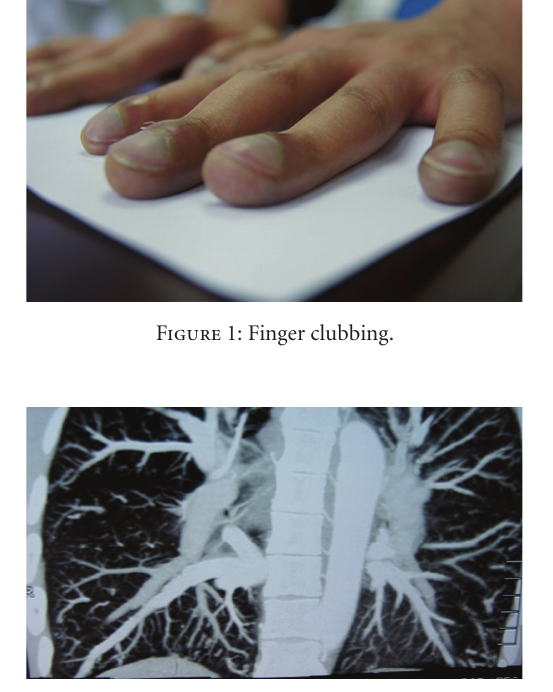
Figure 2: Pulmonary computed tomographic angiography (CTA) shows pulmonary arteriovenous malformation.